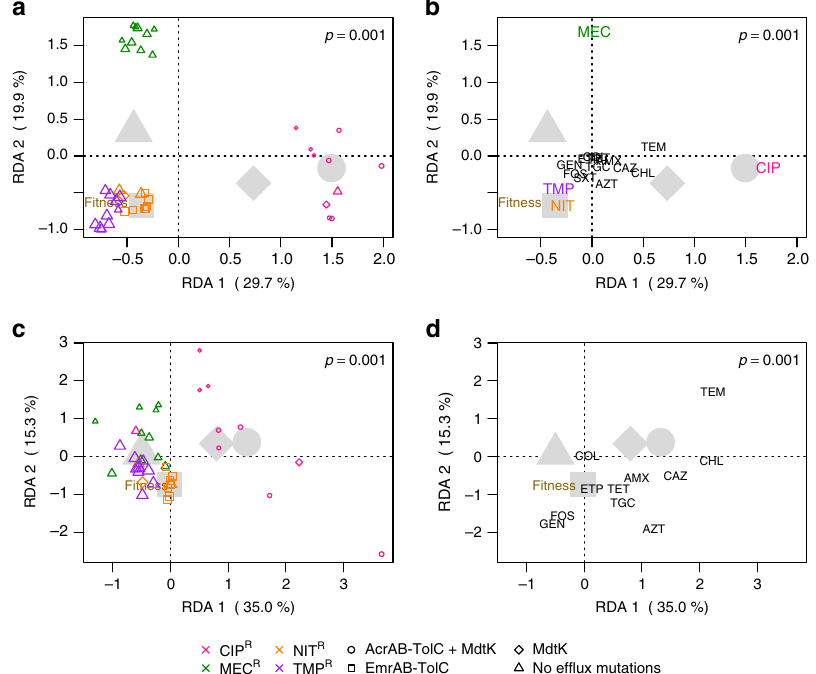
Fig. 3 Results of multivariate statistical modeling. Graphical representations of two redundancy analyses (RDA, triplot) results relating various parameters to the observed changes in IC 90 between resistant mutants and respective wild-type strains for ( a , b ) 16 antimicrobials tested and ( c , d ) a subset of these antimicrobials, excluding cipro fl oxacin, mecillinam, nitrofurantoin, trimethoprim, and trimethoprim-sulfamethoxazole. Each RDA is broken down into two plots; ( a , c ) where weighted averages of resistant mutants are plotted as colored symbols (color indicates resistance group, shape the assigned ef fl ux group, and symbol size proportional to relative fi tness, see Supplementary Fig. 4). In ( b , d ) antimicrobial drug names indicate the tip of vectors that pass through the origin in the direction of increasing IC 90 fold change or CR (direction of steepest ascent). Vectors can be used to interpret the change in IC 90 for the antimicrobials shown. For both statistical models, the fi rst and second RDA axes shown display the majority of explained variation in IC 90 changes. Large gray symbols show centroids (average effect) for all resistant mutants within a given ef fl ux group (shape). The vector tip of relative fi tness (brown) is also shown. a The majority of explained variation is driven by primary resistances, where cipro fl oxacin (pink)-resistant and mecillinam (green)-resistant mutants cluster distinctly from the other resistance groups, which showed higher relative fi tness. b Resistant mutants possessing MdtK mutations alone (diamond) or together with AcrAB-TolC mutations (circle) are likely to show CR to chloramphenicol, ceftazidime, temocillin, and azithromycin, but sensitivity to gentamicin, fosfomycin, and trimethoprim. Whereas those without ef fl ux mutations (triangle) are more likely to display low-level CS or no change to most antimicrobials tested. The analysis of the subset RDA ( c , d ) shows patterns consistent with the full model, but with less clustering of mutants by resistance group ( c ). The combination of AcrAB-TolC and MdtK ef fl ux mutations displayed the greatest fi tness costs, while mutants lacking ef fl ux-related mutations were the most fi t ( d ). RDA signi fi cance was assessed by permutation tests (1000 permutations), where p ≤ 0.05 was considered signi fi cant. For more comprehensive multivariate models see Supplementary Fig. 5 –